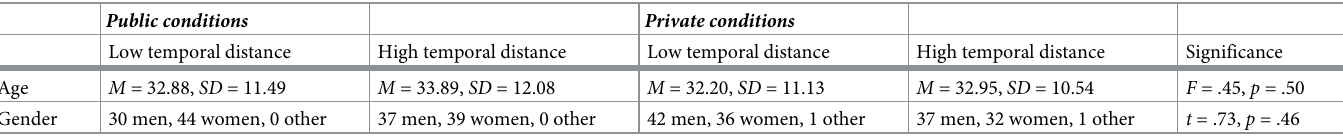
Table 4. Descriptive statistics by experimental condition in Study